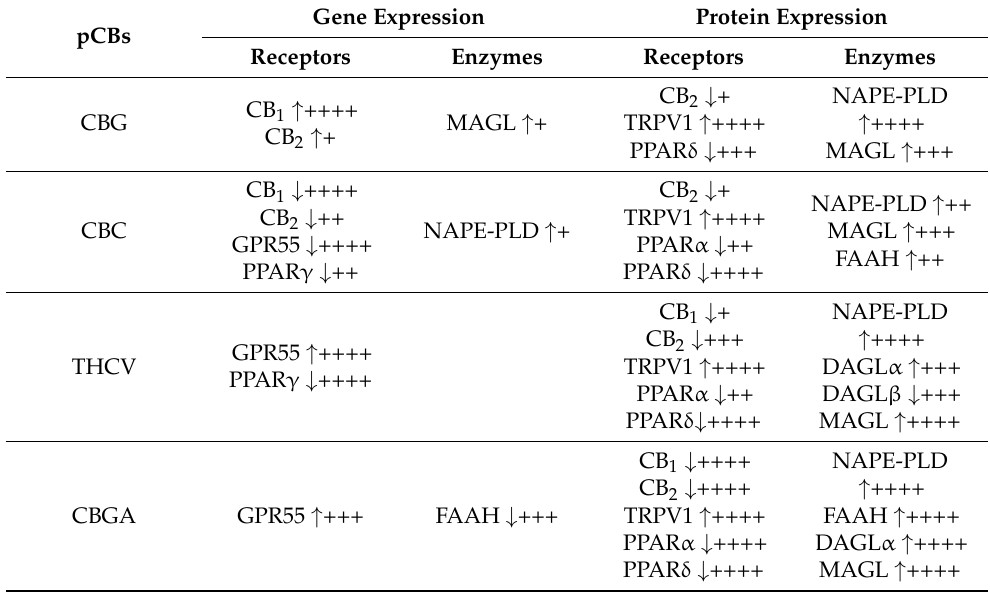
Table 2. Summary of the most significant effects of half-IC 50 doses of pCBs on ECS elements at the gene and protein levels following HaCaT cell treatment for 24 h. Legend: ↑ significant increase; ↓ significant decrease; + p < 0.05, ++ p < 0.01, +++ p < 0.001 and ++++ p < 0.0001 vs. control.